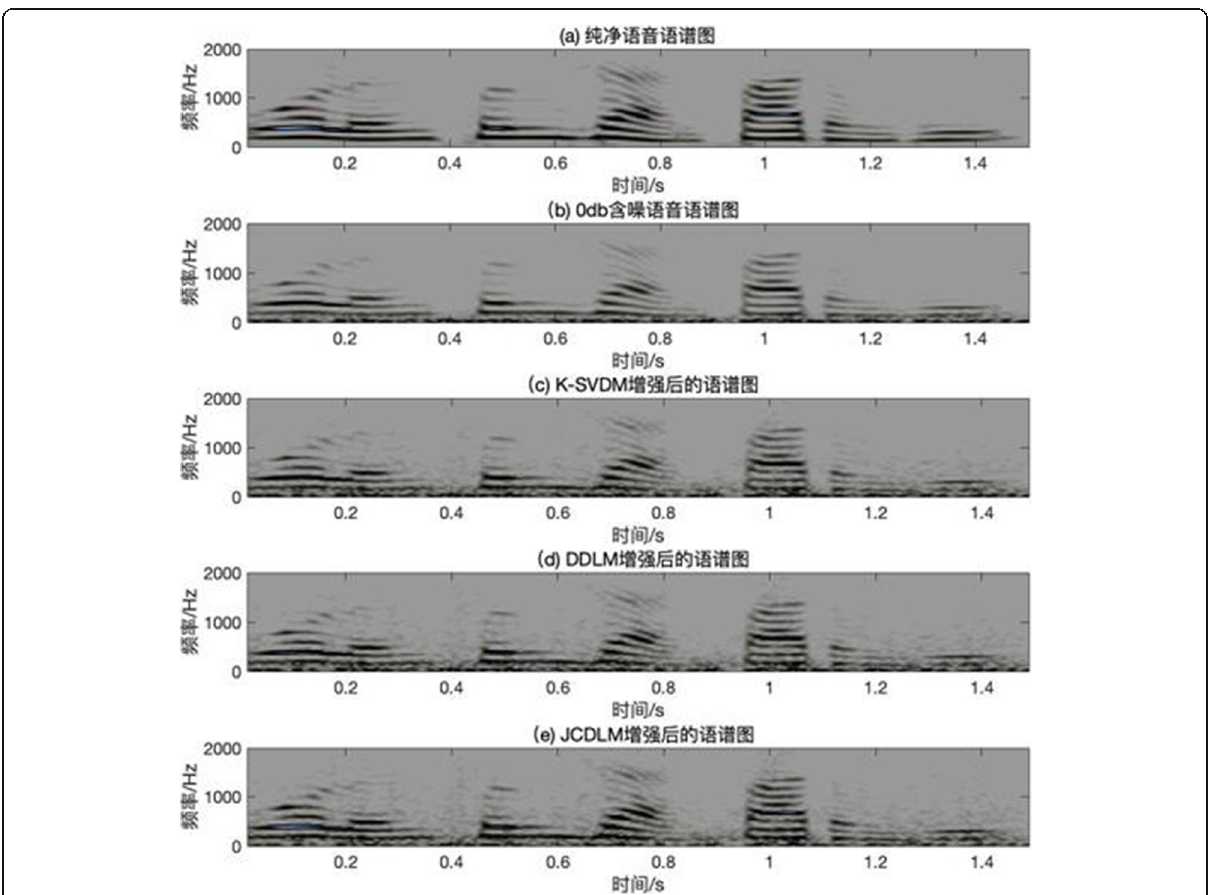
Fig. 9 Spectrum enhanced of different algorithms under 0-dB vehicle